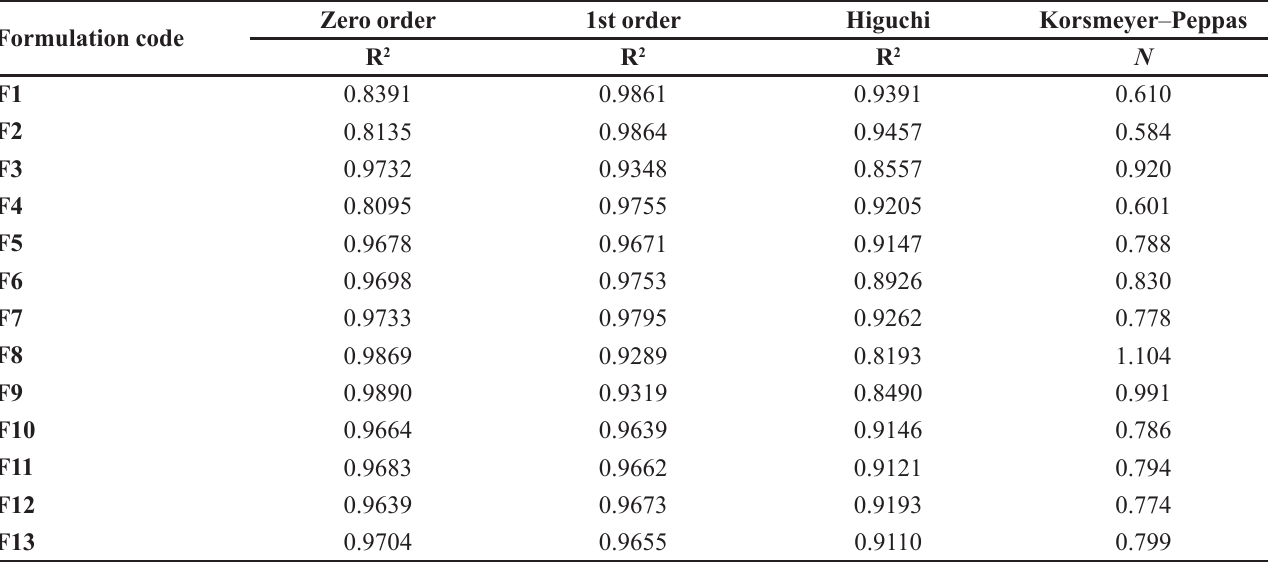
CP and SCMC Formulation